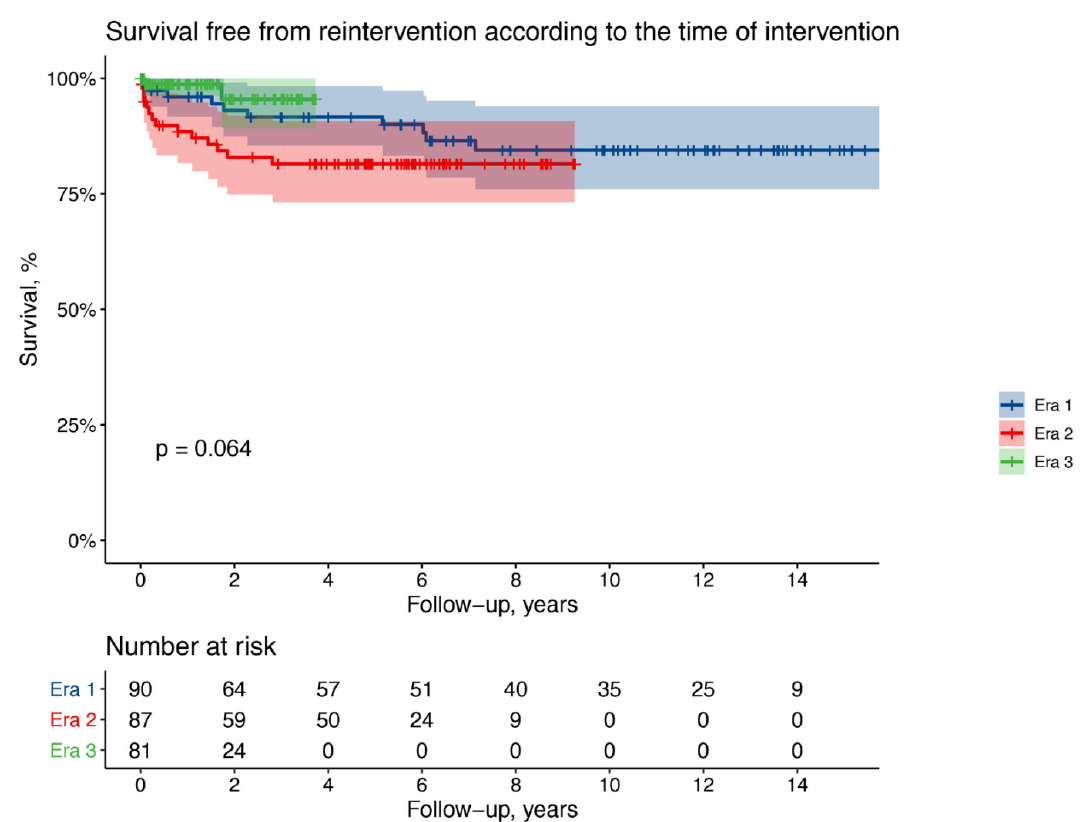
Figure 2. Kaplan–Meier curves showing the freedom from reoperation according to the era of the first intervention.